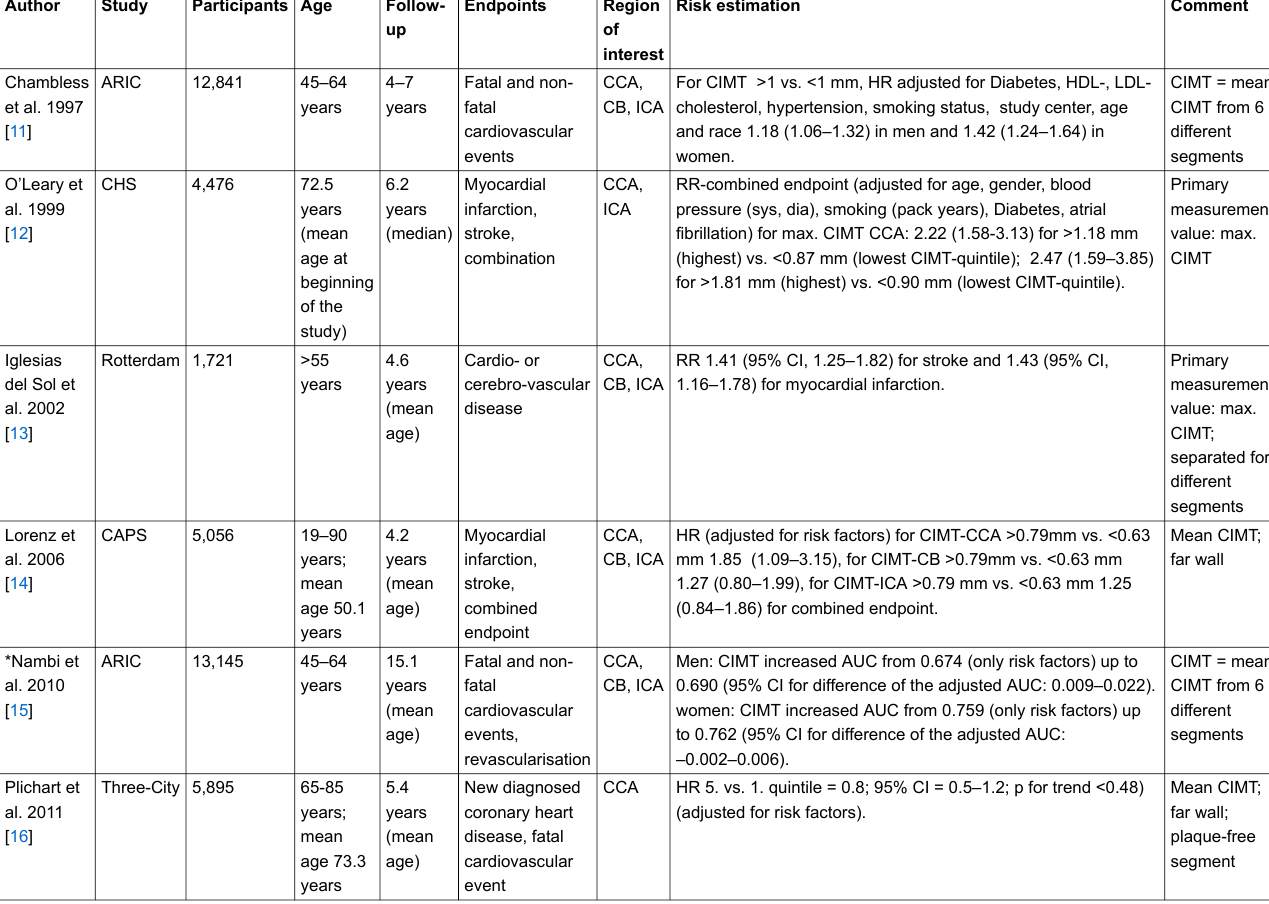
Table 1: Prospective studies about the prediction of cardiovascular events via CIMT-measurement in subjects without manifest cardiovascular atherosclerotic disease. HR = hazard ratio; RR = relative risk; CCA = common carotid artery; CB = carotid bifurcation; ICA = internal carotid artery); * = follow-up [11].